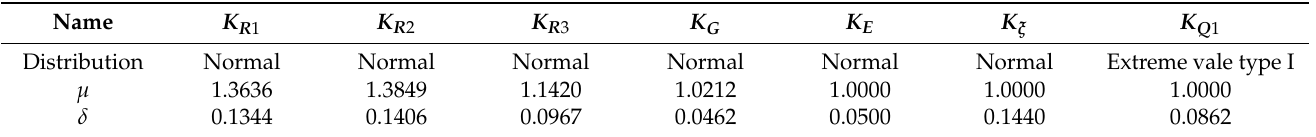
Table 3. Basic information of each uncertainty